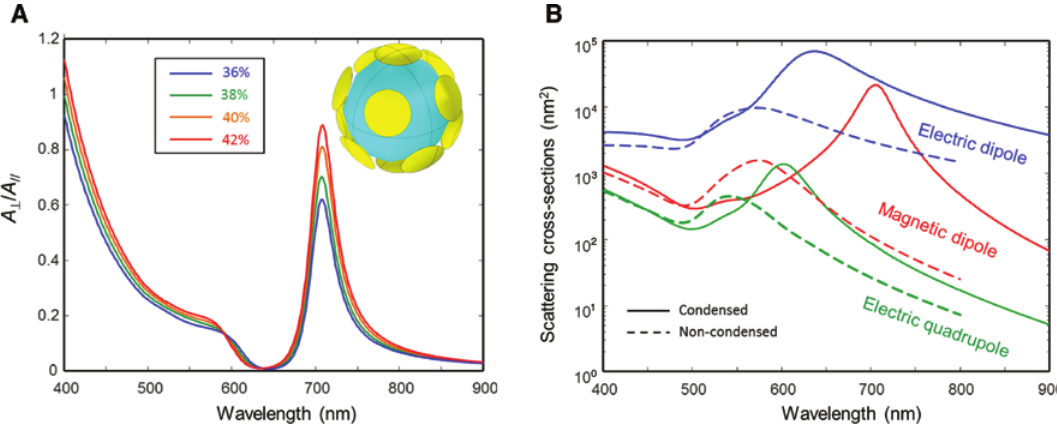
Figure 9: Simulated optical properties of condensed dodecapods. (A) Calculated plots of the computed magnetic to electric estimator A / A versus wavelength for different volumes of gold aggregates in ⊥ // condensed dodecapods. The inset in the top right represents a typical model of the patchy dodecapod used in the finite element simulation. The percentages in the legend are those taken from Figure 8A and the objects have identical volumes of gold and identical values of the core particles as well as R . (B) Simulated scattering cross-sections of the electric (blue) and magnetic dipoles (red) as well as the electric Au quadrupole (green) in both noncondensed (dashed line) and condensed (continuous line)